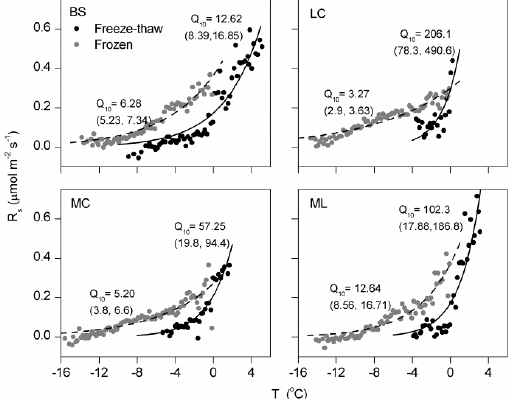
Figure 3. Soil respiration (R s ) as a function of soil temperature (T s ) during days with soil freeze-thaw cycles and days where the soil remains frozen, at four microsites including bare surface (BS), lichen crust (LC), moss crust (MC), and mixed crust of both moss and lichen (ML). Data points are bin-averaged hourly data using a T s increment of 0.2 °C. The solid and dashed lines are fitted curves using the Q 10 model (equation 1) for freeze-thaw and frozen periods, respectively. Values in parentheses are the 95% confidential interval (CI) derived from the Q 10 function.